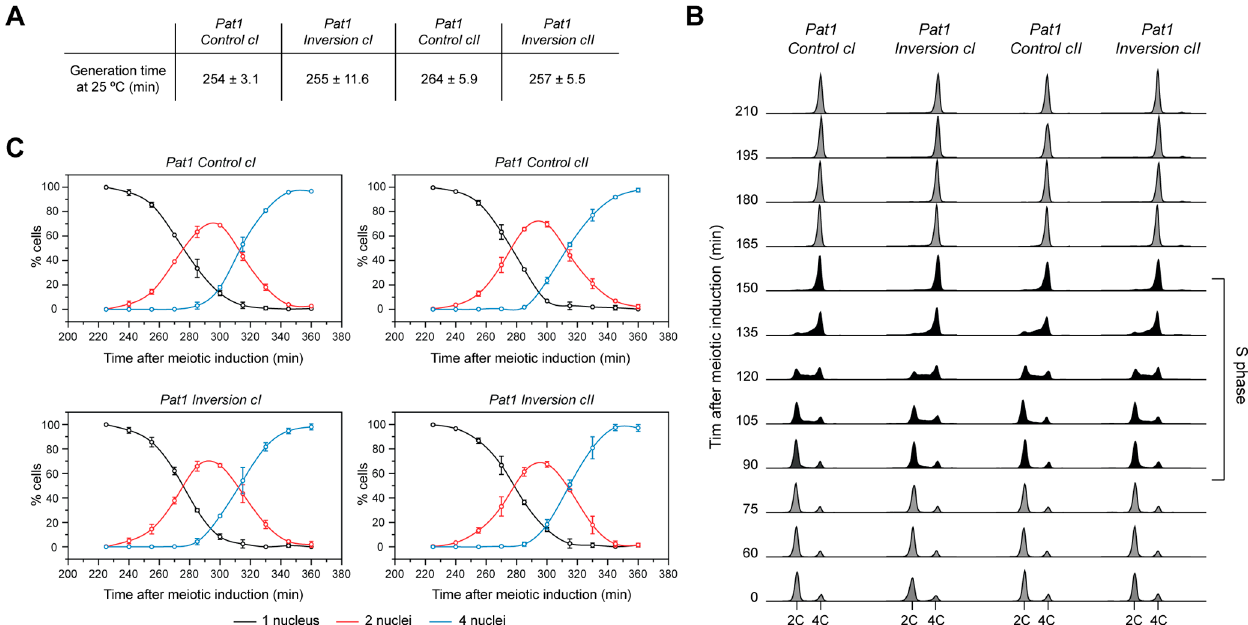
Figure 4. Characterization of meiotic entry and progression in strains with chromosomal rearrange- ments. ( A ) Generation times of diploid pat1-114 strains with chromosome I and II inversions, along with their pre-rearrangement controls. Averages and standard errors of three independent experi- ments are shown. ( B ) Flow cytometry analysis of cells undergoing meiosis. Cells were depleted of nitrogen for 16 h, then shifted to 34 °C upon addition of NH 4 Cl to induce meiotic entry (T = 0). Time points during which cells undergo bulk pre-meiotic S phase are indicated in black. S phase onset and duration are identical in the different strains. ( C ) Time course of meiotic progression. Cells were ethanol fixed and stained with DAPI at the indicated time points to assess the number of nuclei. Graphs represent the average of two independent experiments (n > 300 for each time point; error bars: standard deviations). Cells with two nuclei have completed meiosis I, while those with 4 nuclei have completed meiosis II. No changes in meiotic progression are detected in the strains harboring chromosomal inversions.